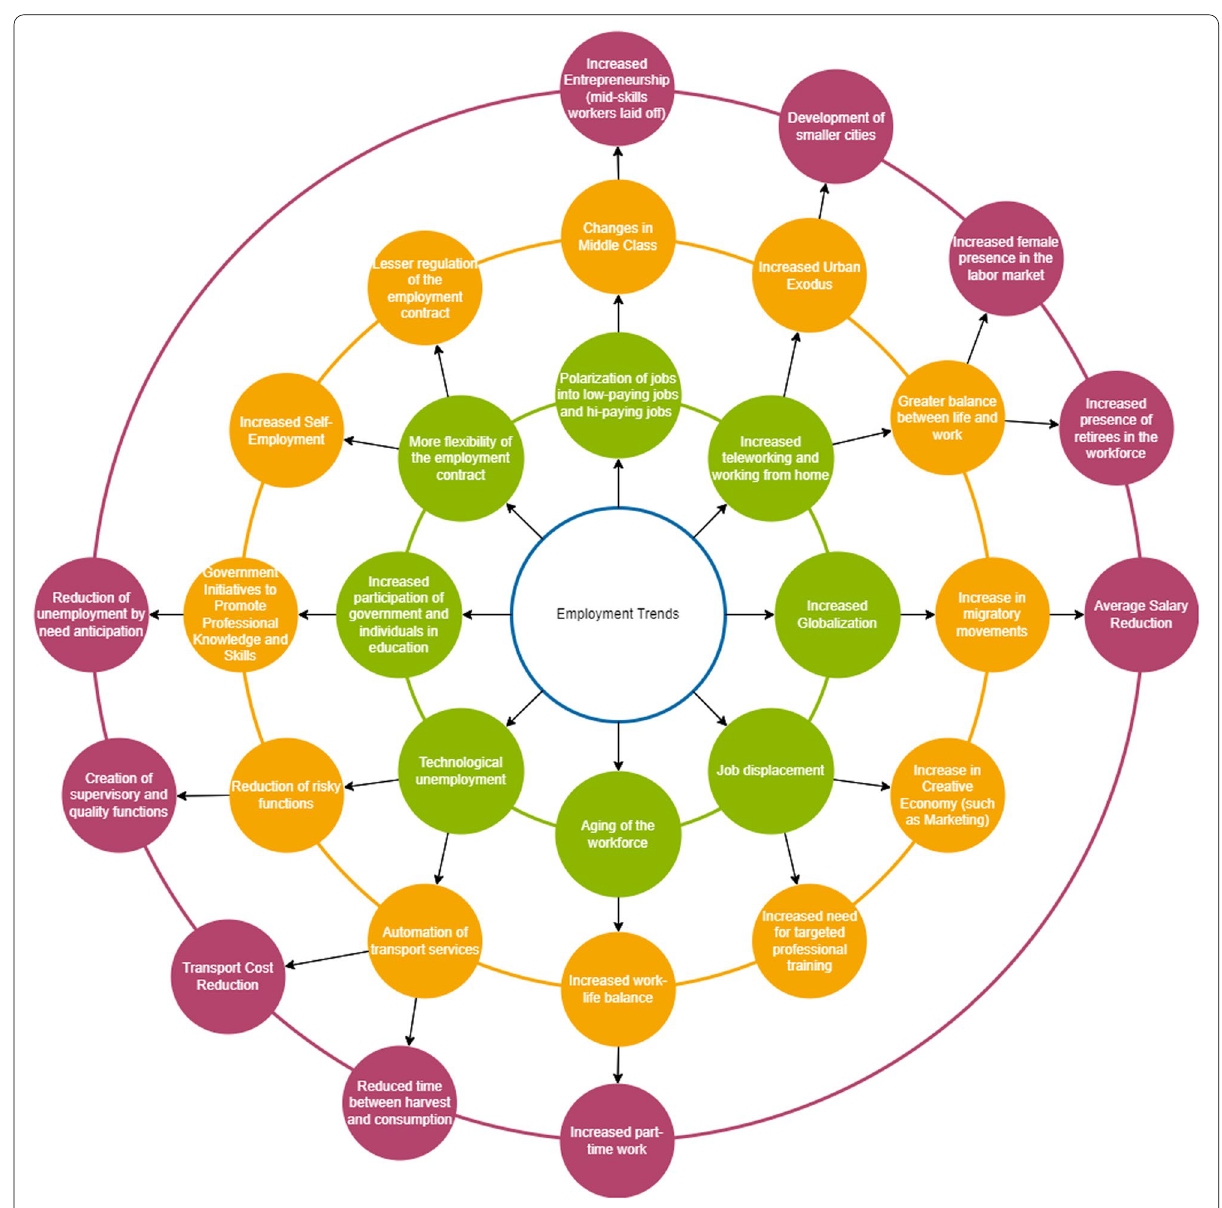
Fig. 3 Futures wheel from the employment